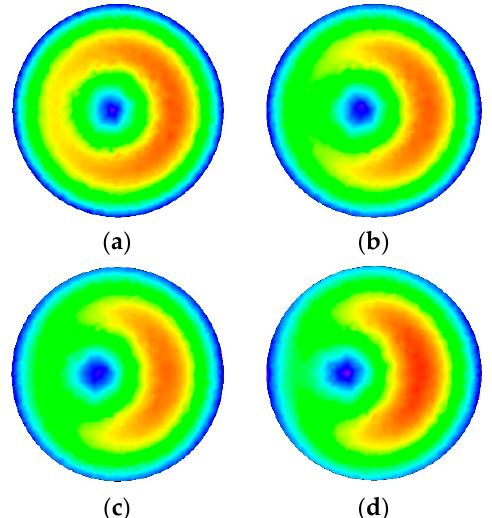
Figure 30. Distribution diagrams of magnetic field strength with the proposed structure and different